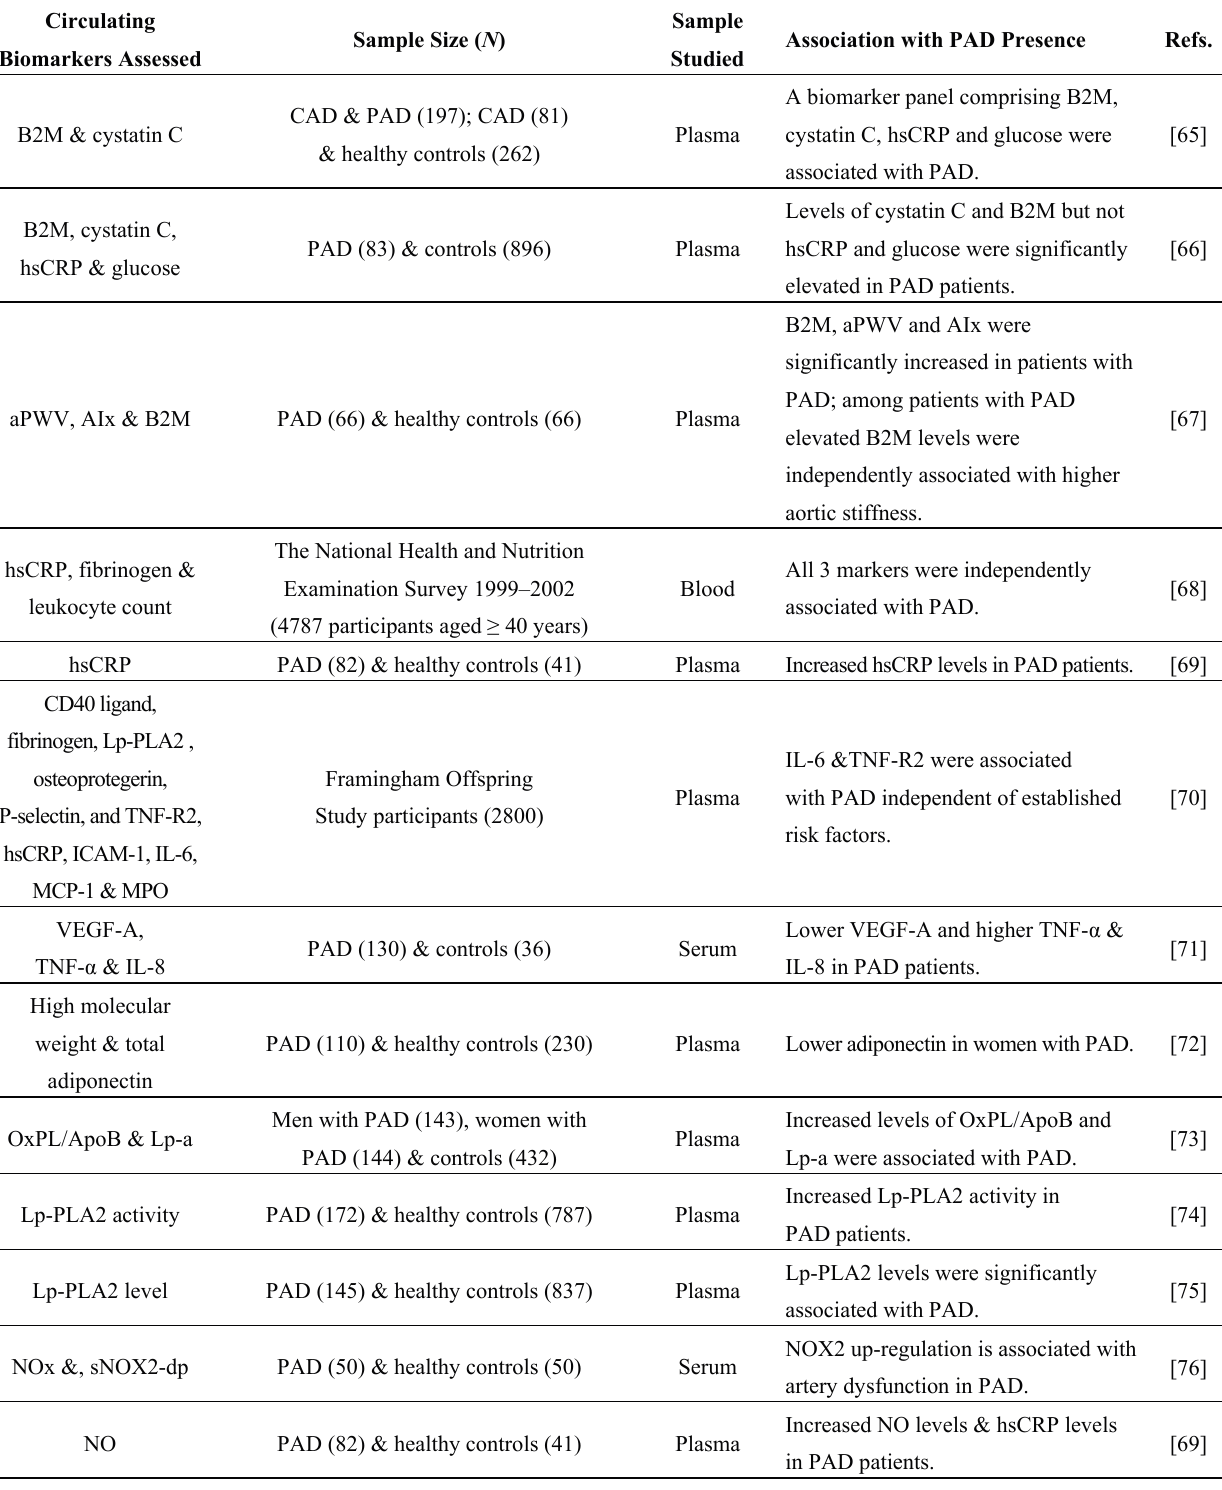
Table 1. Examples of circulating biomarkers reported to be associated with peripheral artery